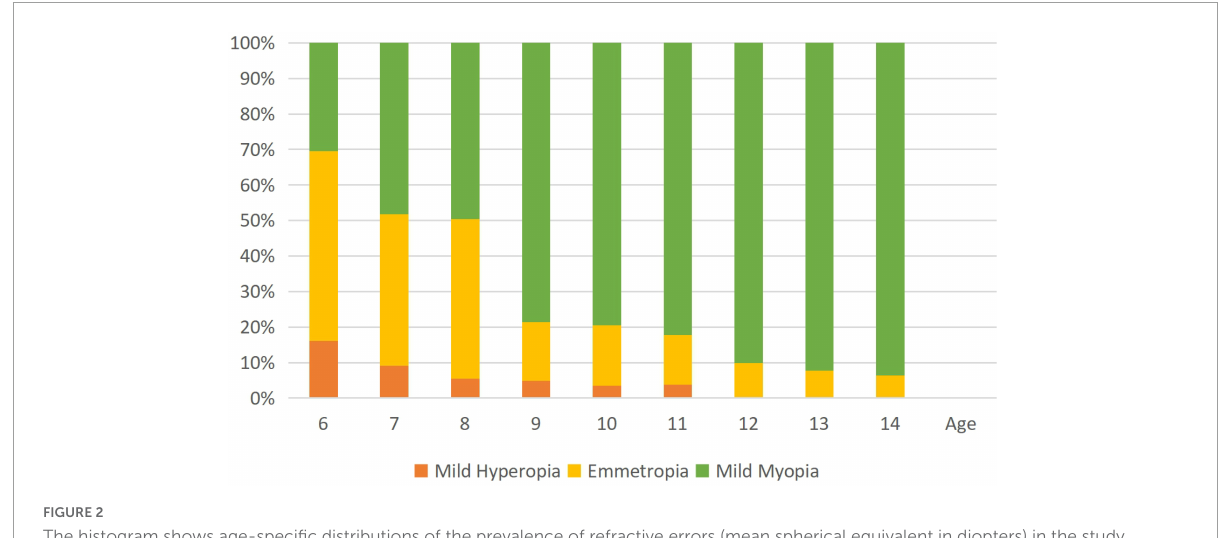
FIGURE2 The histogram shows age-specific distributions of the prevalence of refractive errors (mean spherical equivalent in diopters) in the study population. Mild hyperopia is defined as +0.50 D ≤ spherical equivalent refraction (SER) < +3.00 D; emmetropia is defined as –0.50 D < SER < +0.50; and mild myopia is defined as –3.00 D ≤ SER < –0.50 D.